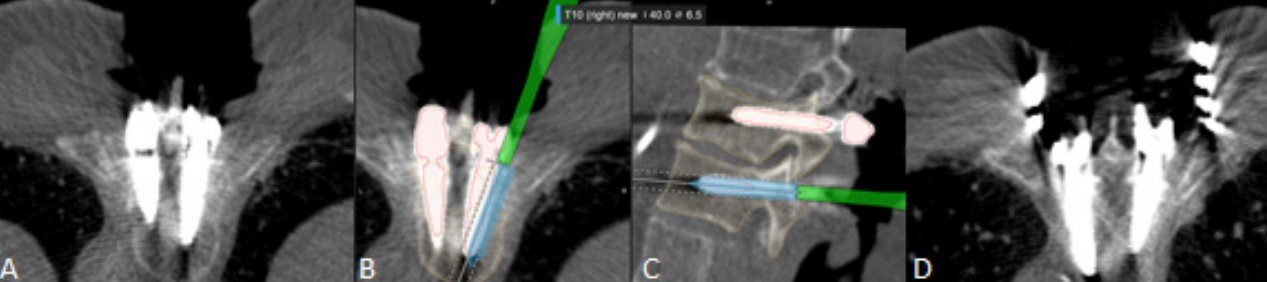
Figure 8. Intraoperative Th10 screw revision in patient number 4. After registration iCT, robotic-guided stabilization was performed for Th9-10 and control iCT scan was performed. ( A ). Axial view of control iCT shows GRS grade D Th10 screw on the right side with correct position of all other screws. The screw was removed and then repositioned using robotic alignment. ( B ). axial and ( C ). sagittal view of the screw revision. Screws were segmented for better visualization and orientation. The screw was implanted along the presented trajectory (blue). ( D ). Axial view of control iCT shows GRS grade A Th10 screw on the right side.